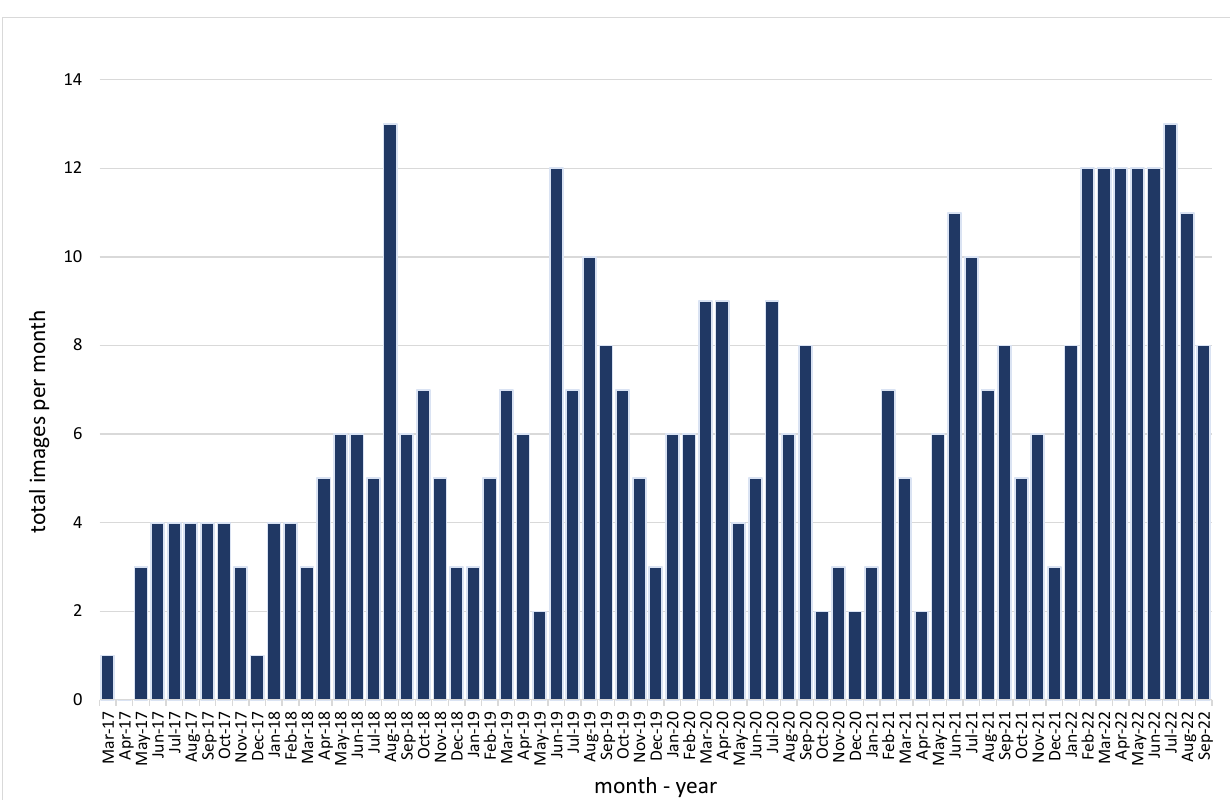
Figure 3. Total Sentinel 2 (Level 2A) used in this study per month (period from April 2017 until September 2022). Table 1. Linear correlation coefficient of the four areas using the ARVI